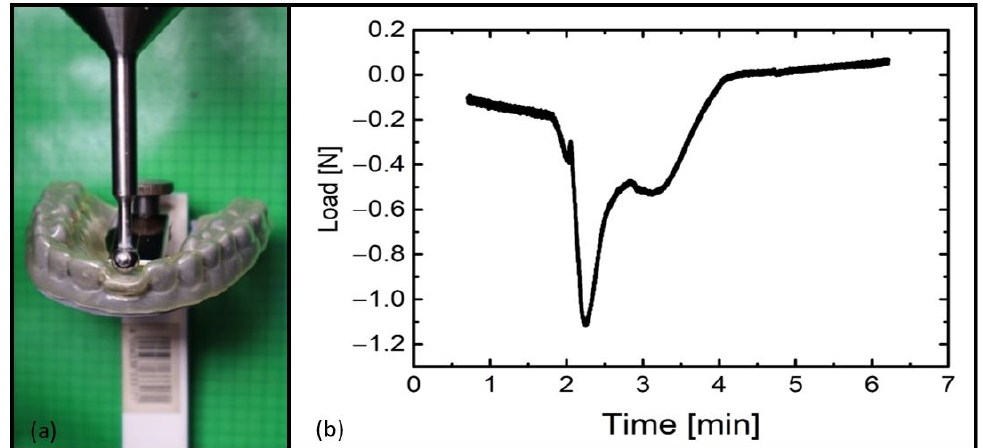
Figure 9. Experimental setup to determine the shape recovery force of a TPU aligner ( a ) and the corresponding measurement curve ( b ). corresponding measurement curve ( b